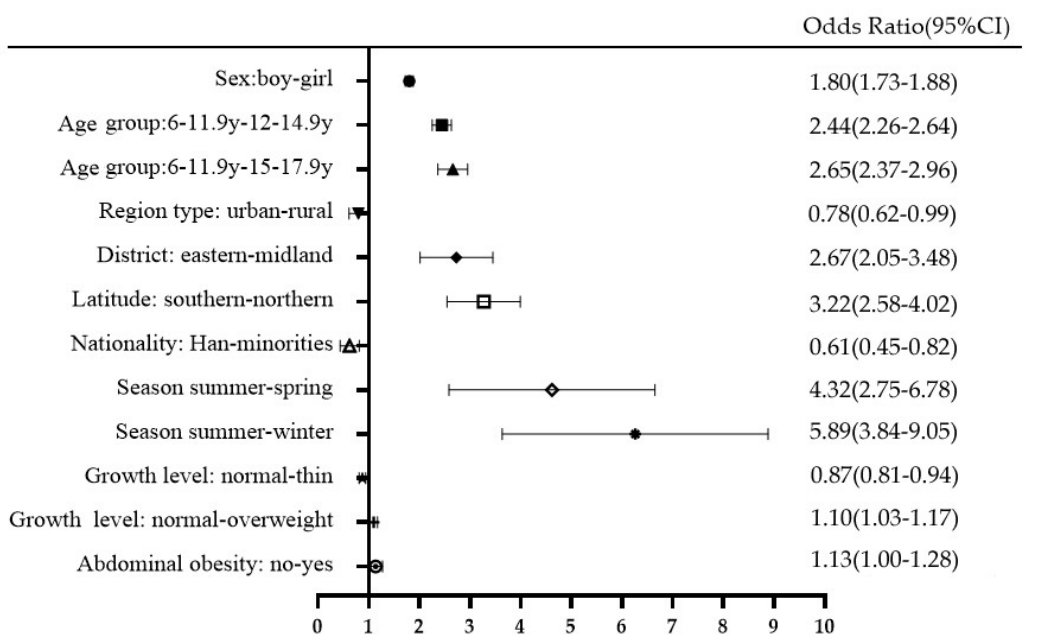
Figure 1. Risk factors for vitamin D inadequacy in CNNHS 2016 – 2017 (vitamin D insufficiency and